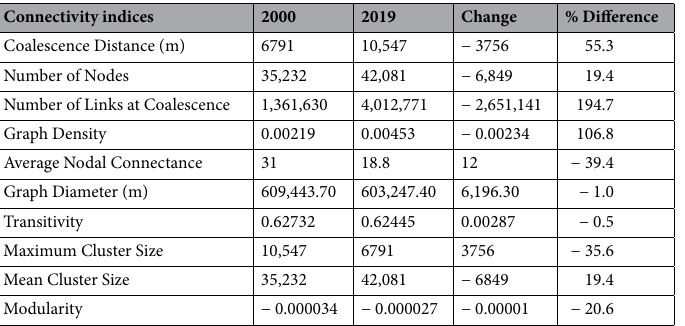
Table 2. Overall-network connectivity metrics for networks of forest remnants in eastern Paraguay in 2000 and